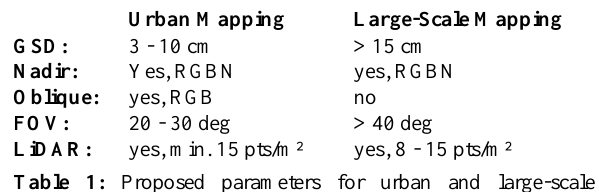
Table 1: Proposed parameters for urban and large-scale mapping sensors